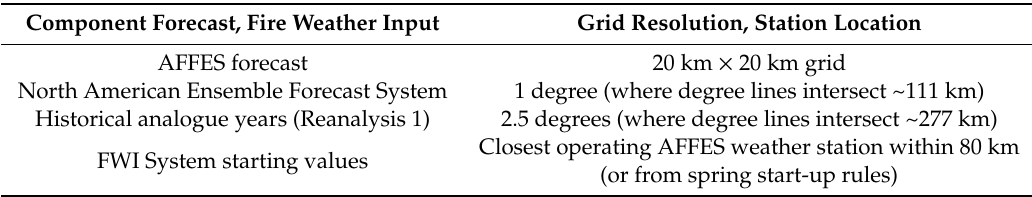
Table 1. Spatial resolution of component forecasts and location of fire weather